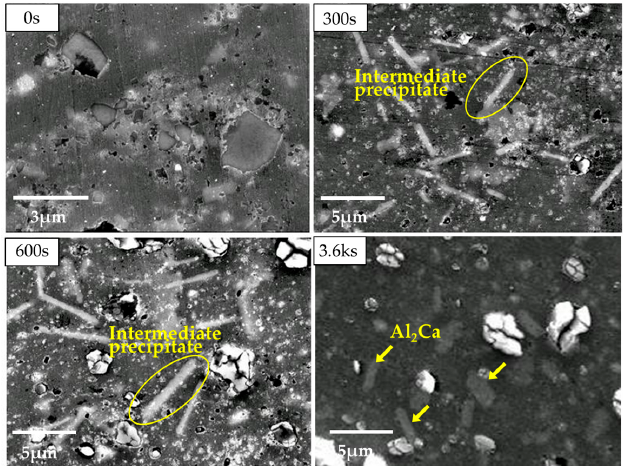
Figure 1. Scanning electron microscopy (SEM) observation on the Mg-Al-CaO precursors with 10-vol % CaO particles after the heat treatment at 500 ◦ C for 0 s, 300 s, 600 s and 3.6